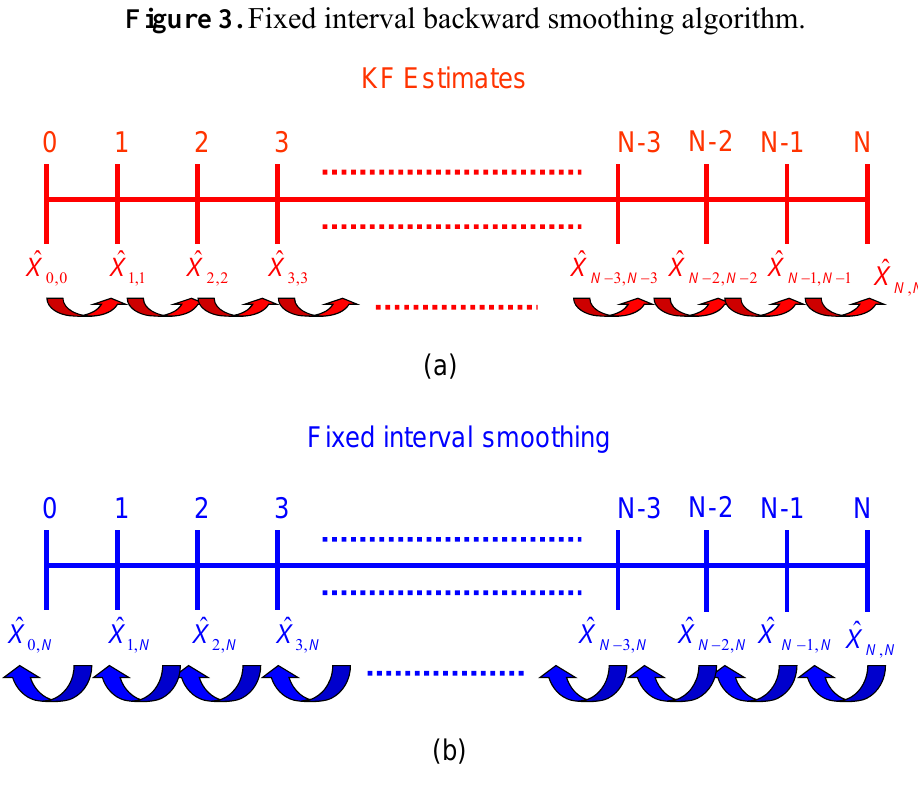
Figure 3. Fixed interval backward smoothing